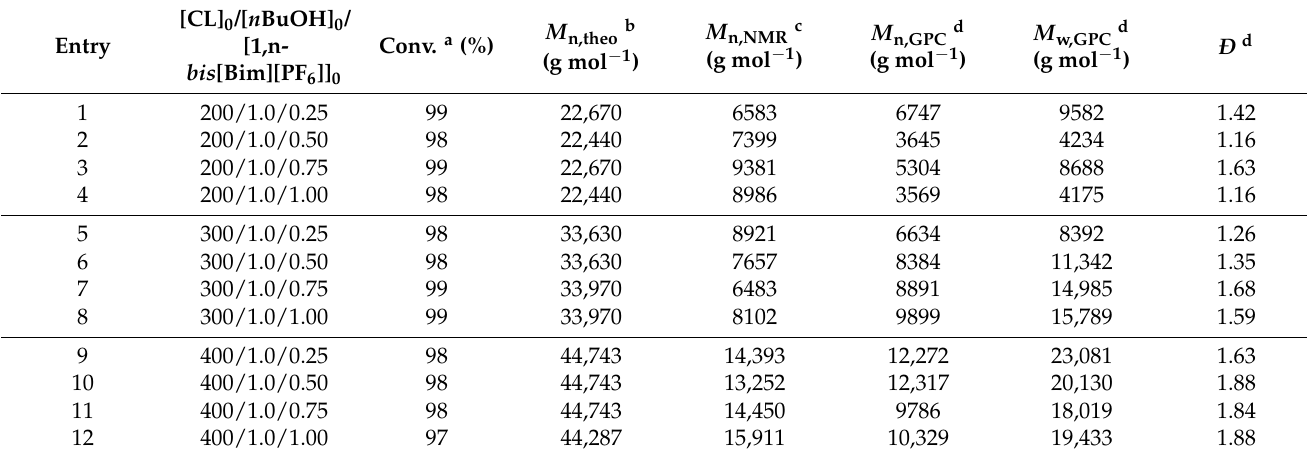
Table 1. The molecular weight averages, molecular weight distribution, and % conversion for the ROP of CL catalyzed